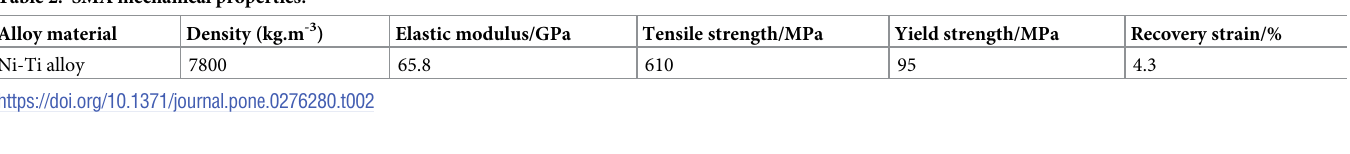
Table 3. SMA wire transition temperature.